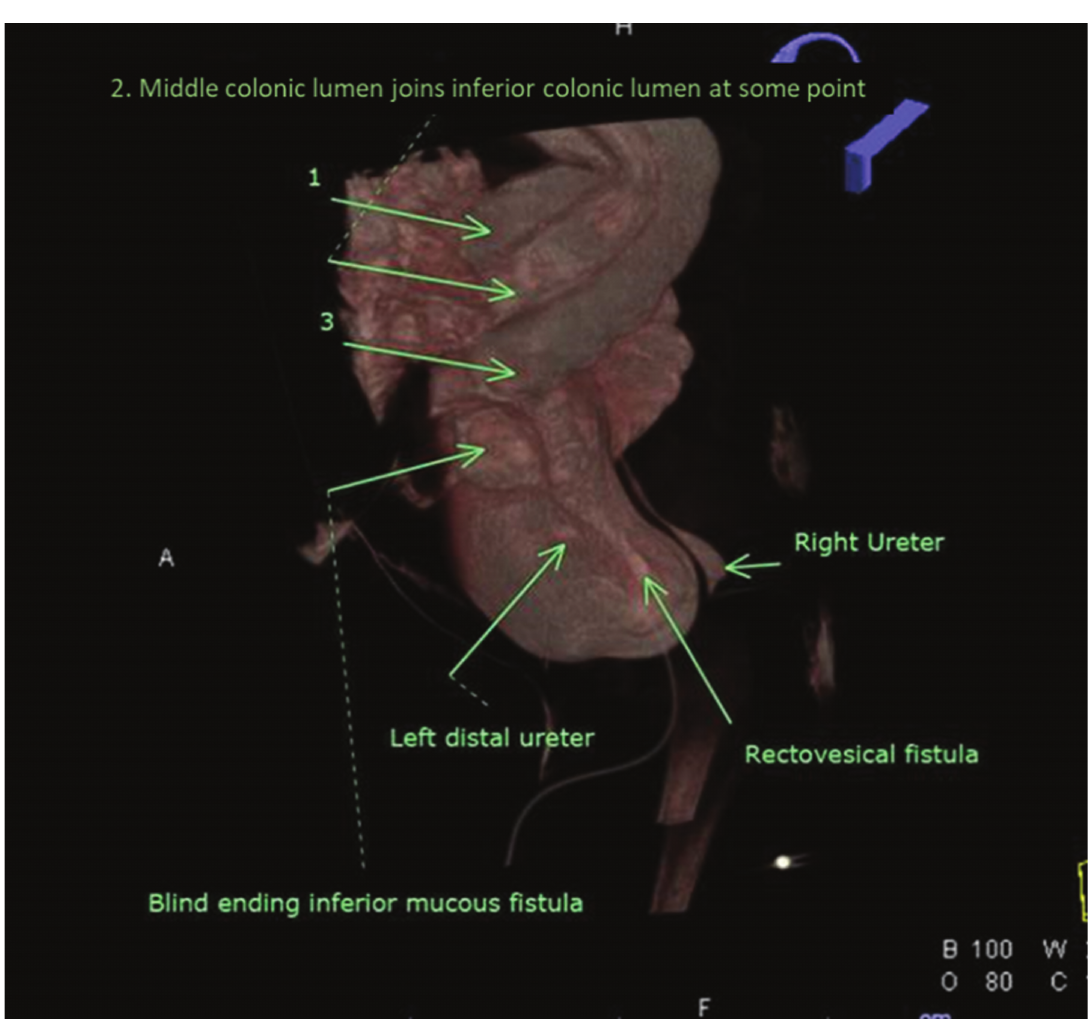
Fig. 2 High-resolution three-dimensional imaging showing three colonic lumens of proximal colon, distal colon with one blind ending lumen, and one fi stulizing to the